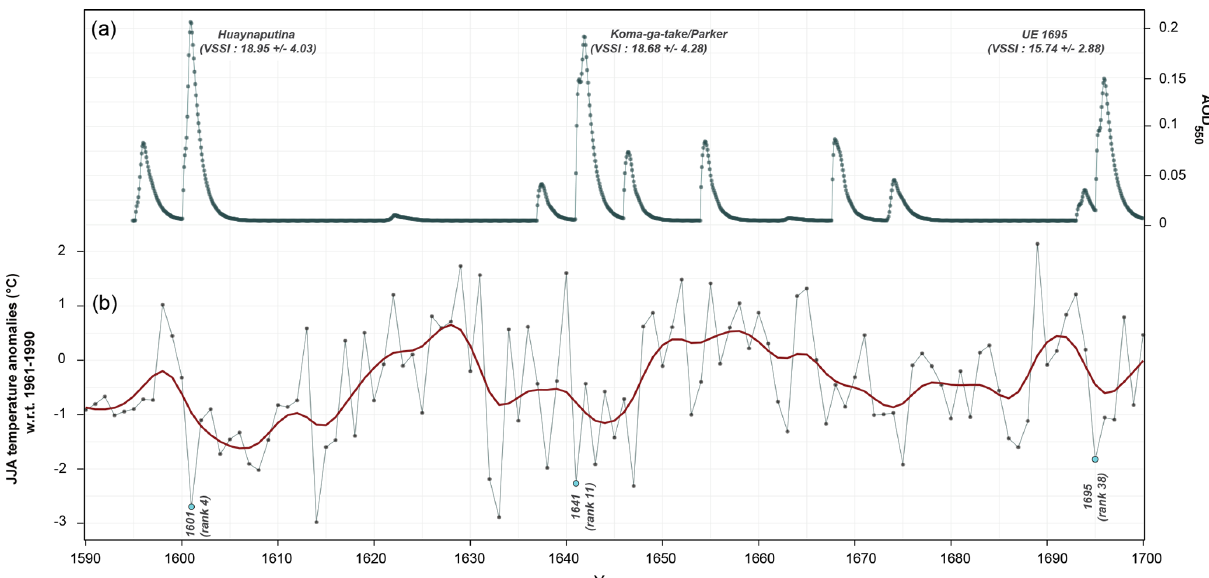
Figure 3. Three major eruptions are recorded in ice-core records for the 17th century in 1600 (Huaynaputina), 1640–41 (Koma-ga-take and Mount Parker), and 1695 (unidentified eruption): (a) stratospheric aerosol optical depth (SAOD) estimated for the latitude of Ostrobothnia using the Volv2k_v2 EVA AOD 500–1900 (Toohey and Sigl, 2017) dataset; (b) summer (JJA) temperature anomalies (with respect to 1961– 1990) reconstructed for the period 1590–1700 over Ostrobothnia. Note that cold years followed the three major volcanic events but were also reconstructed for years without volcanic activity (e.g., 1614, 1633).